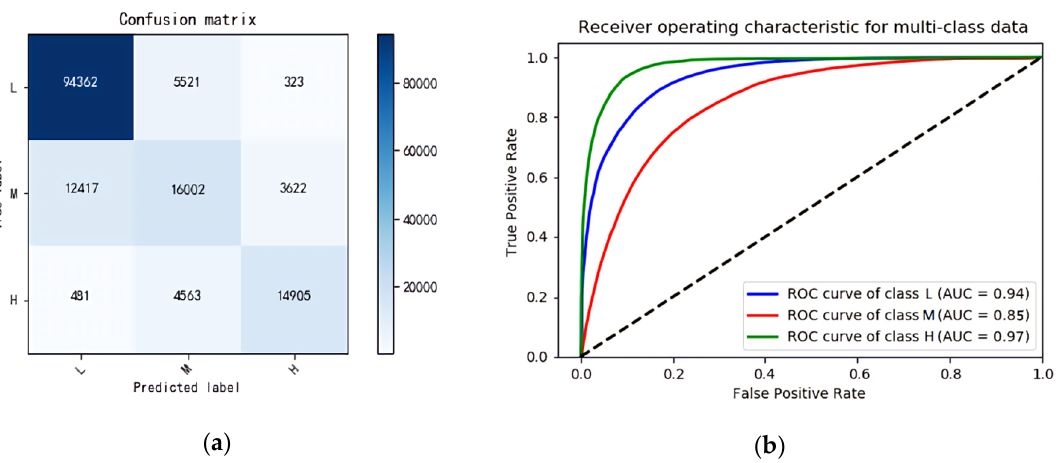
Figure 6. ( a ) Confusion matrix of the decision tree; ( b ) Receiver operating characteristic (ROC) curves of the decision tree. Table 4. Validation results of the indicators in the optimal decision tree model.